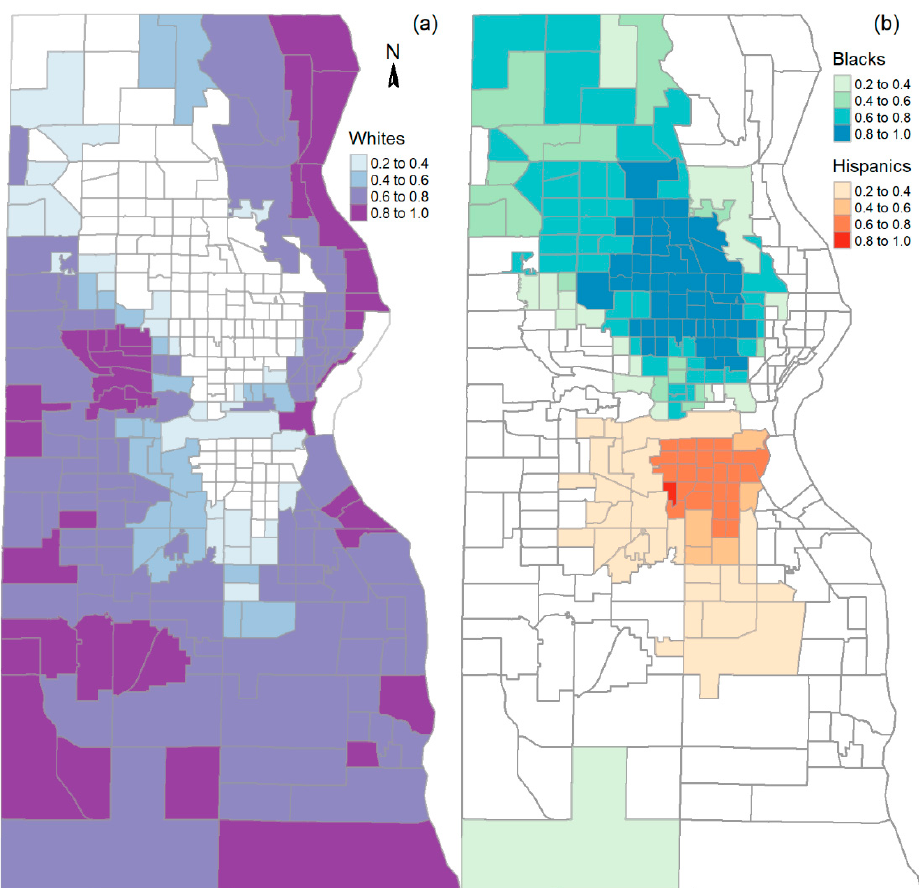
Figure 1. Spatial distribution of the proportions of non-Hispanic Whites ( a ), Blacks and Hispanics ( b ) in census tracts in Milwaukee County (based on 2020 census redistricting summary file).